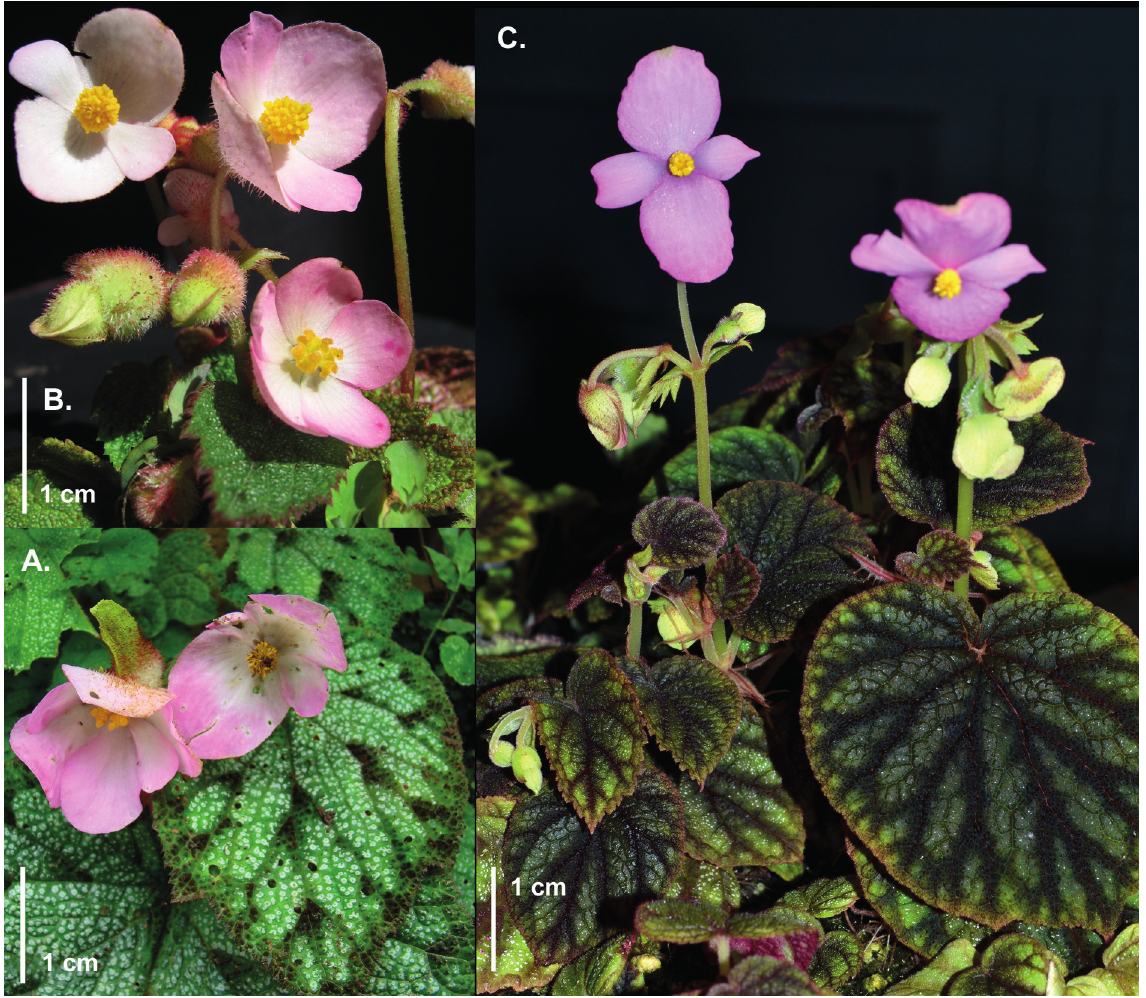
Fig. 49. Begonia picta Sm. A . Male and female flowers and light leaf form. B . Male and female flowers and buds. C . Male flowers and dark leaf form. Photographs A & B courtesy of Sangeeta Rajbhandary of wild plants in Nepal, photograph C courtesy of Darrin Norton of a cultivated plant in a private